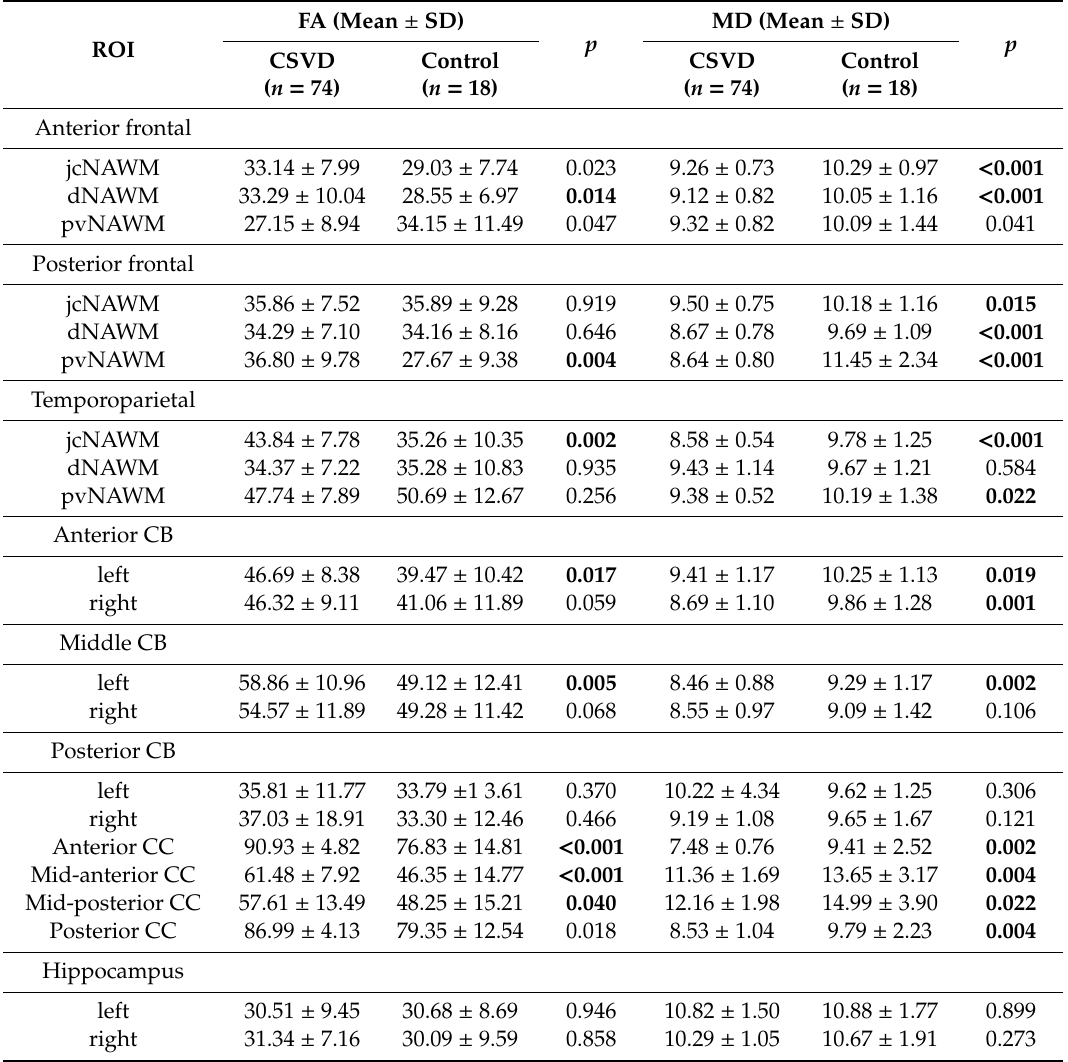
Table 2. Fractional anisotropy (FA) and mean di ff usivity (MD) for di ff erent ROIs in the subjects with CSVD and the